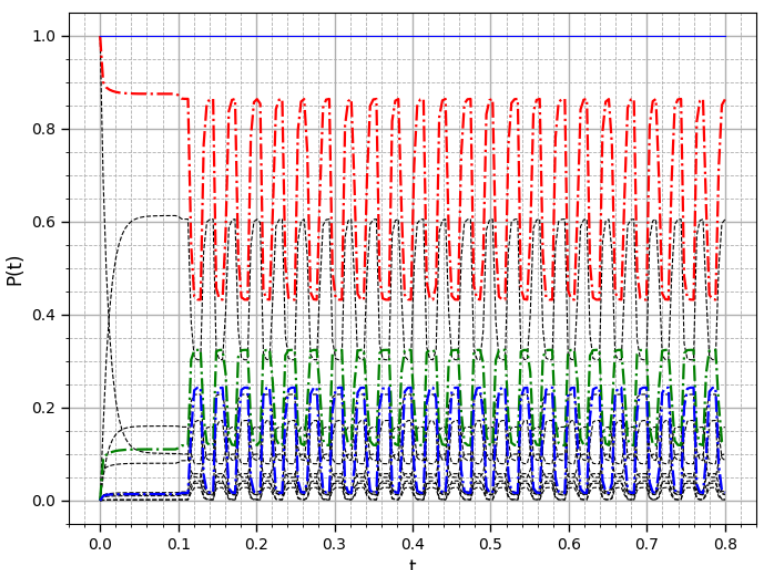
Figure 9. Dependencies of the probabilities of states with a periodic abrupt change in the arrival intensity ( λ 1 = 10 packets/s, λ 2 = 500 packets/s, t 1 = 0.015 s, t 2 = 0.015